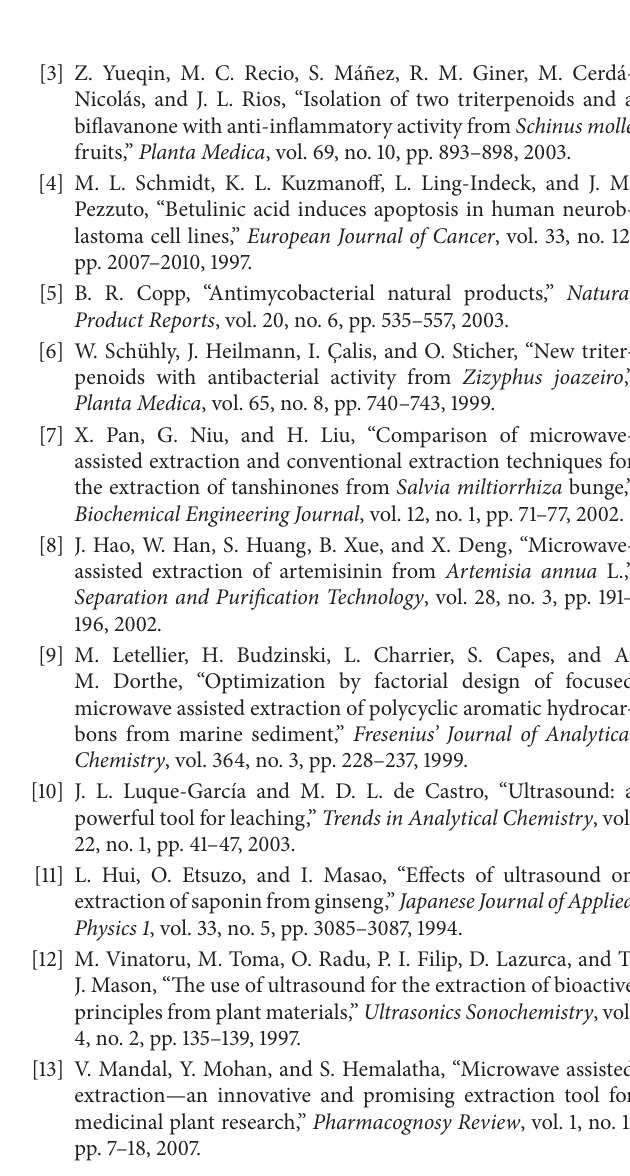
Table 3: ANOVA for response surface quadratic model to verify whether developed model is significant or nonsignificant. Source Sum of squares Degree of freedom Mean square 𝐹 -value Model 0.21985 9 0.024 10.6998 0.0005 Significant 𝐴 -pH 0.00052 0.0005 0.22679